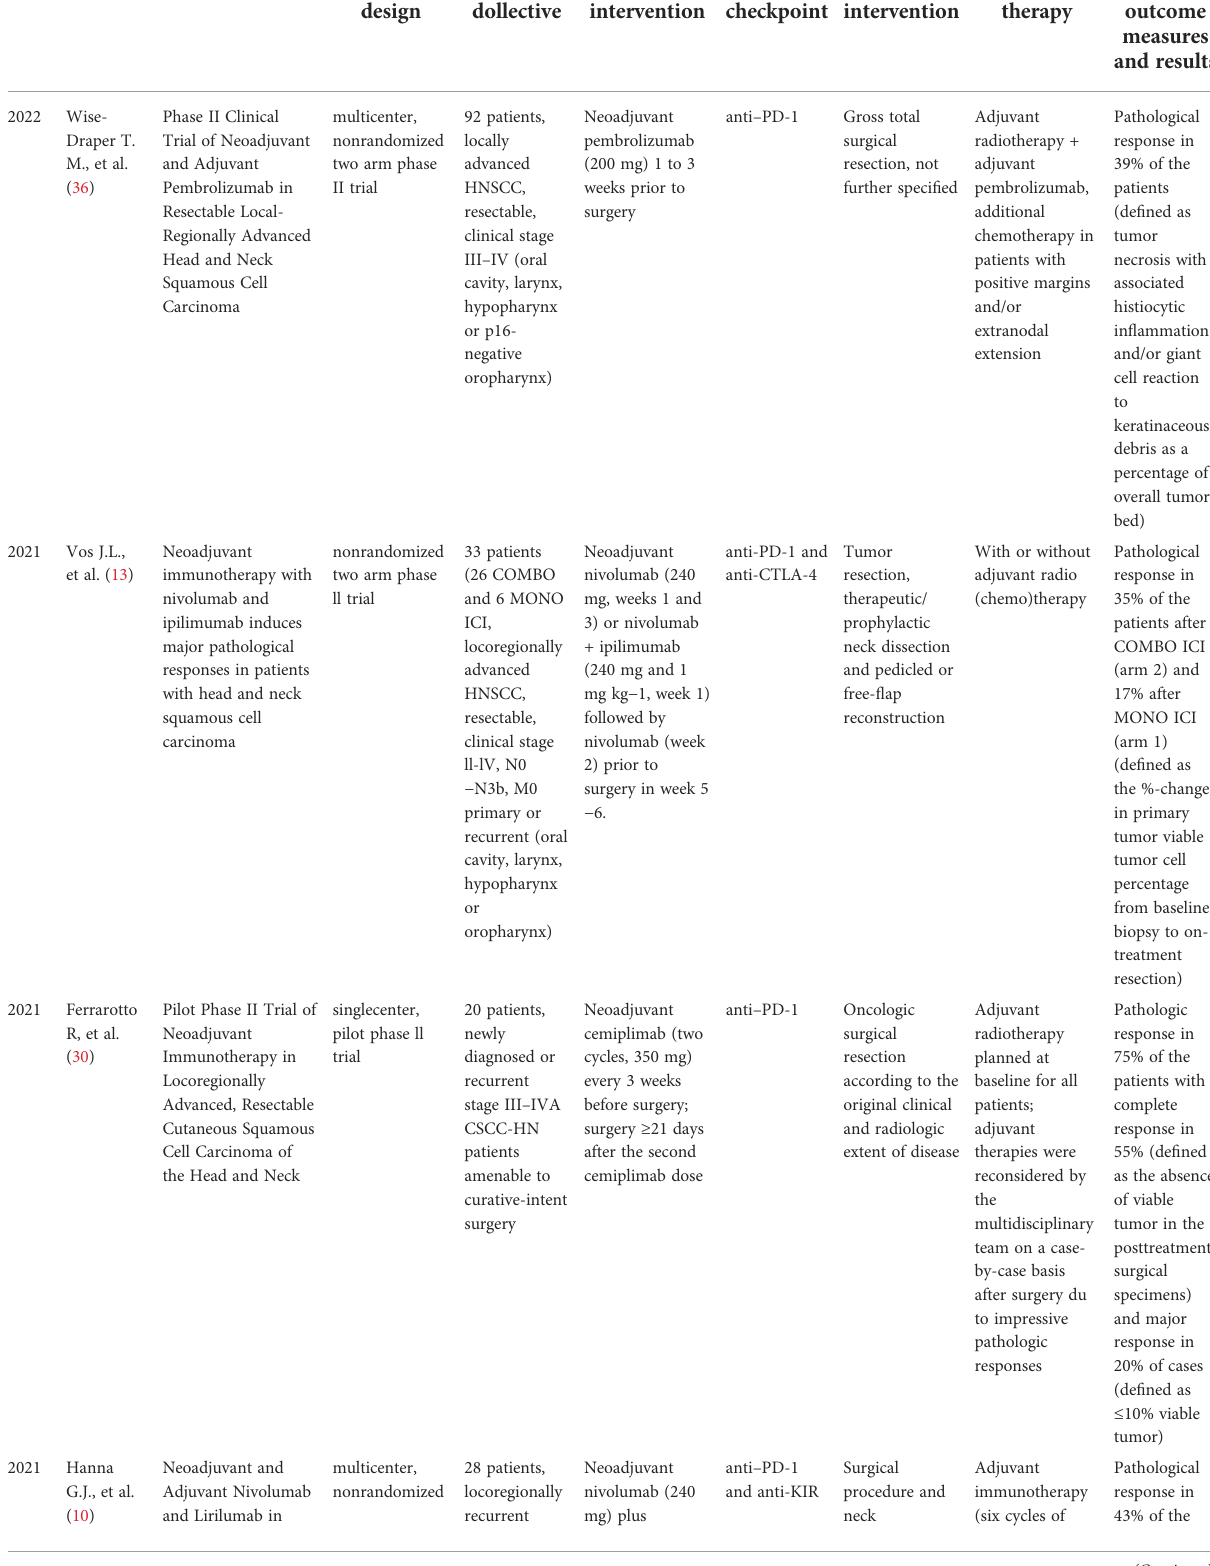
TABLE 1 Human studies on neoadjuvant Immunotherapy in